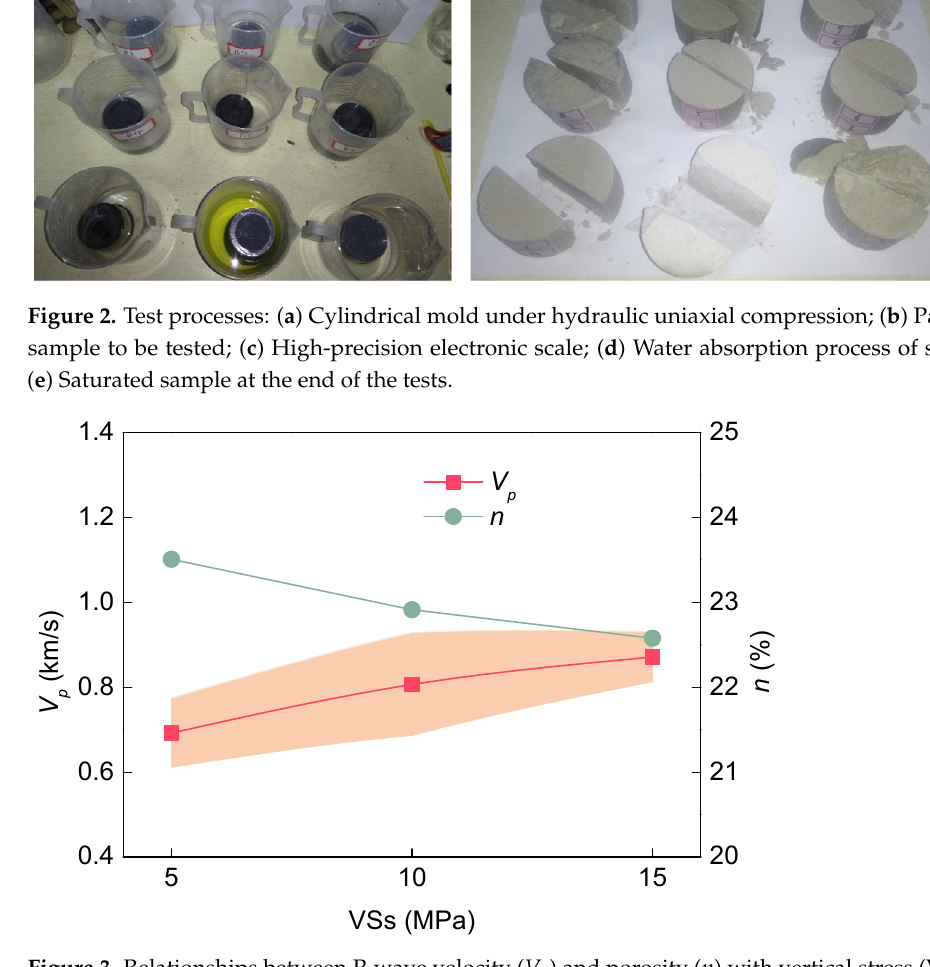
p ) and porosity ( n ) with vertical stress